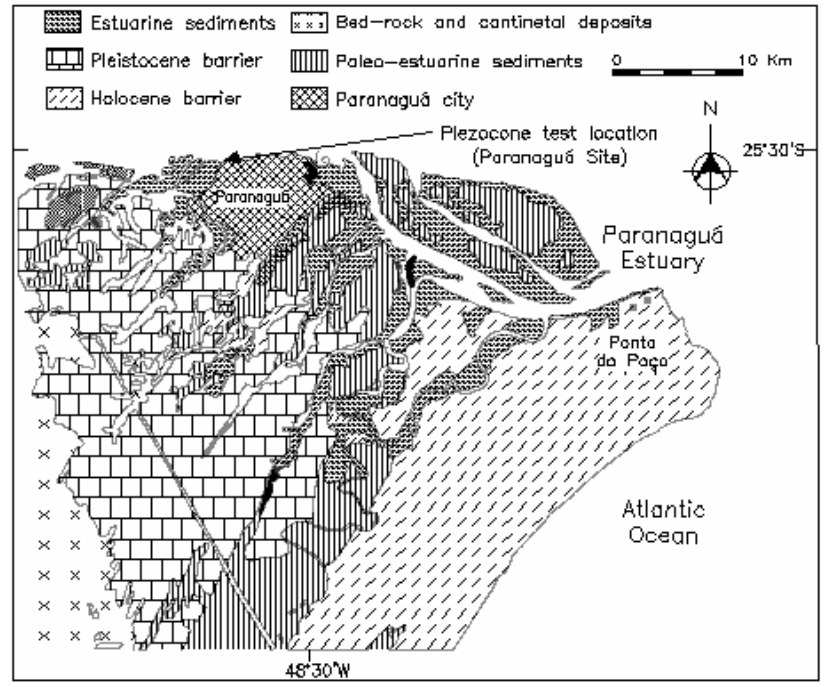
Fig. 7 – Geological setting of Paranagua region, indicating geologic units distribution and the site location. (Modified from Lessa and Angulo